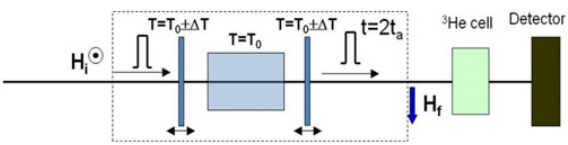
Figure 3. Scheme of the storage variant for the crystal-diffraction nEDM search